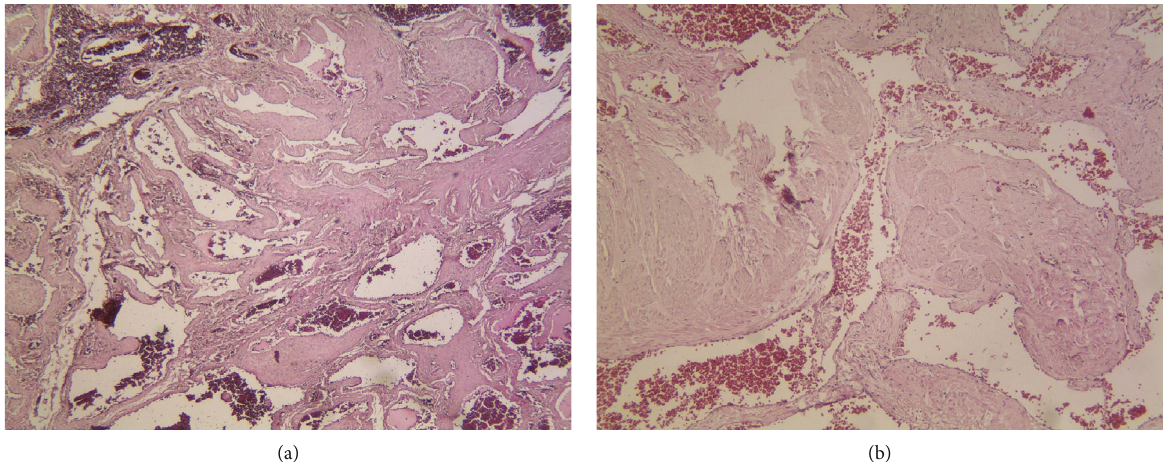
Figure 6: (a) Thin blood vessels with papillary projections in the fi brous stroma ( × 40). (b) Paralleling pattern of fascicle and glomus cells around the blood vessels ( × 100).